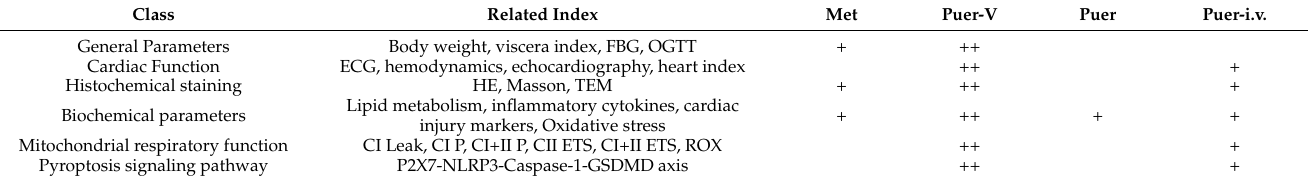
Figure 12. A mechanism diagram. Puerarin-V improves mitochondrial respiration and cardiac function in streptozotocin–isoproterenol induced myocardial injury via inhibiting pyroptosis pathway through P2X7 receptors. Table 2. The differences in pharmacological activity. +: protection effect; ++: better protection effect.